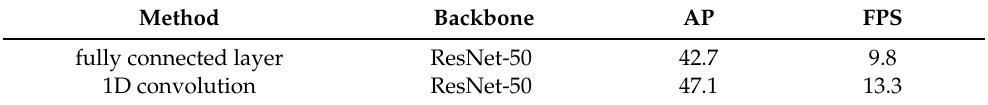
Table 2. Comparison between fully connected layer and 1D convolution for channel weight attention.